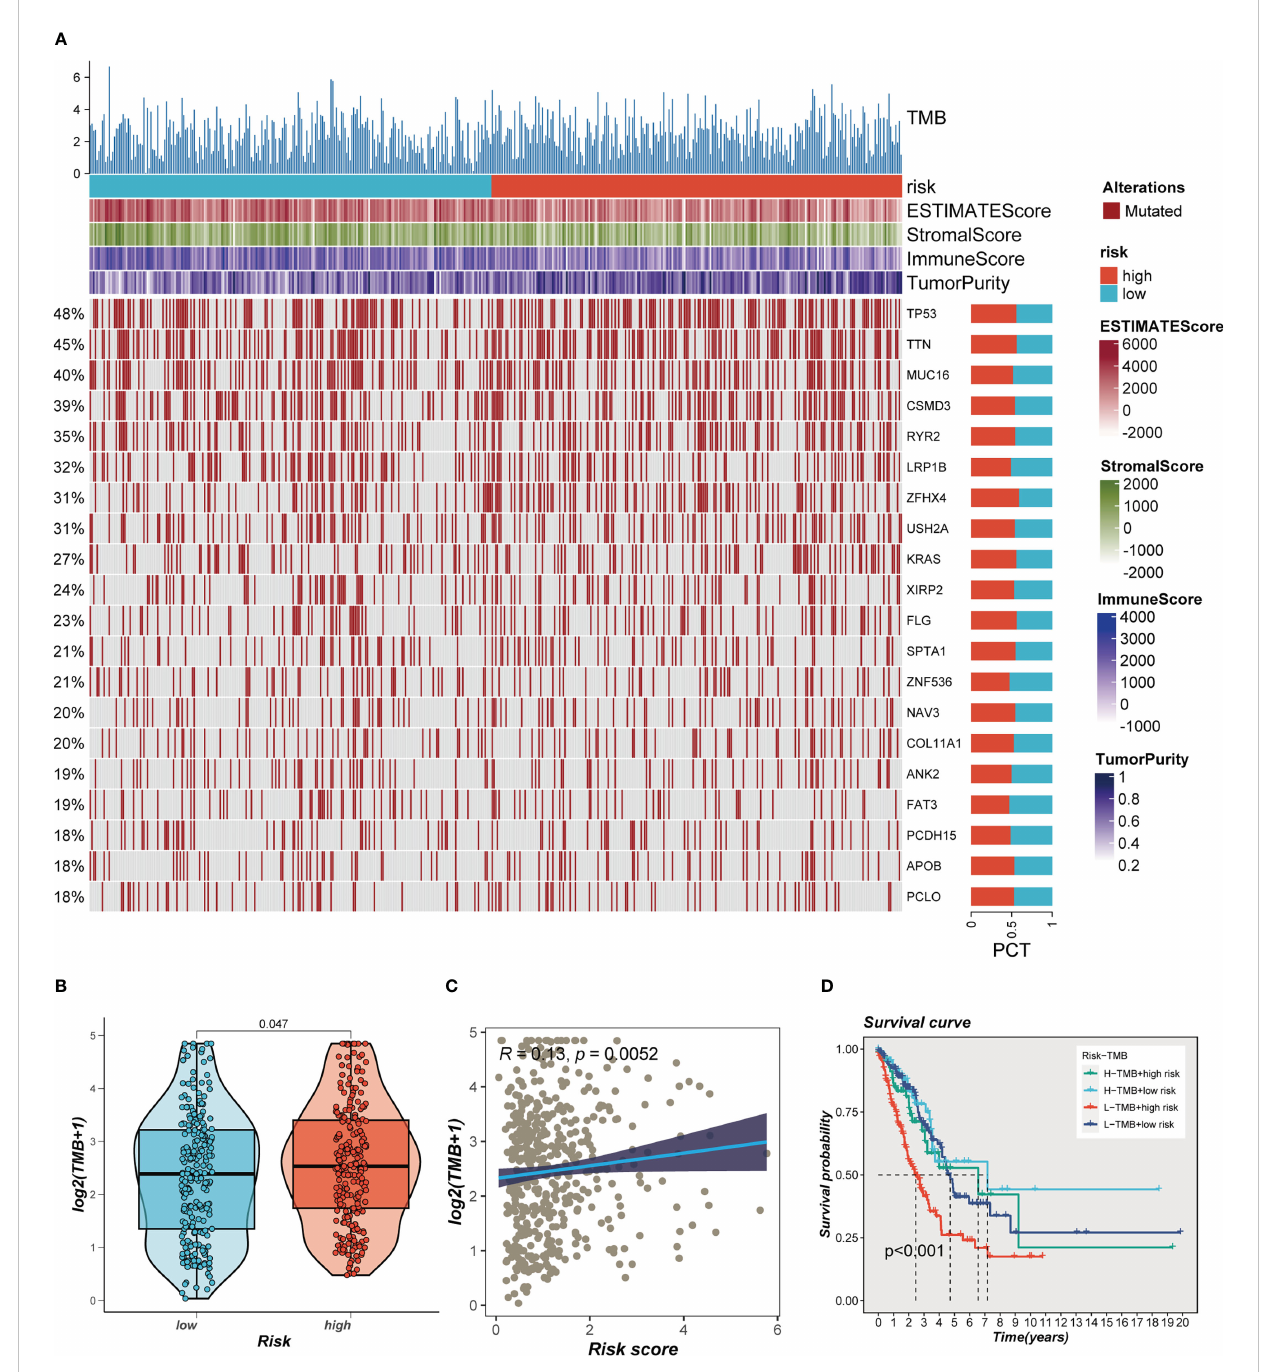
FIGURE 7 Landscape of LUAD sample mutation pro fi les. (A) Mutation landscape of the top 20 genes with mutation frequency in differential risk subgroups. (B) Comparison of tumor mutation burden (TMB) between different risk groups. (C) Correlation analysis between risk score and TMB. (D) Survival differences for four different subgroups (H-TMB+high-risk, H-TMB+low-risk, L-TMB+high-risk, and